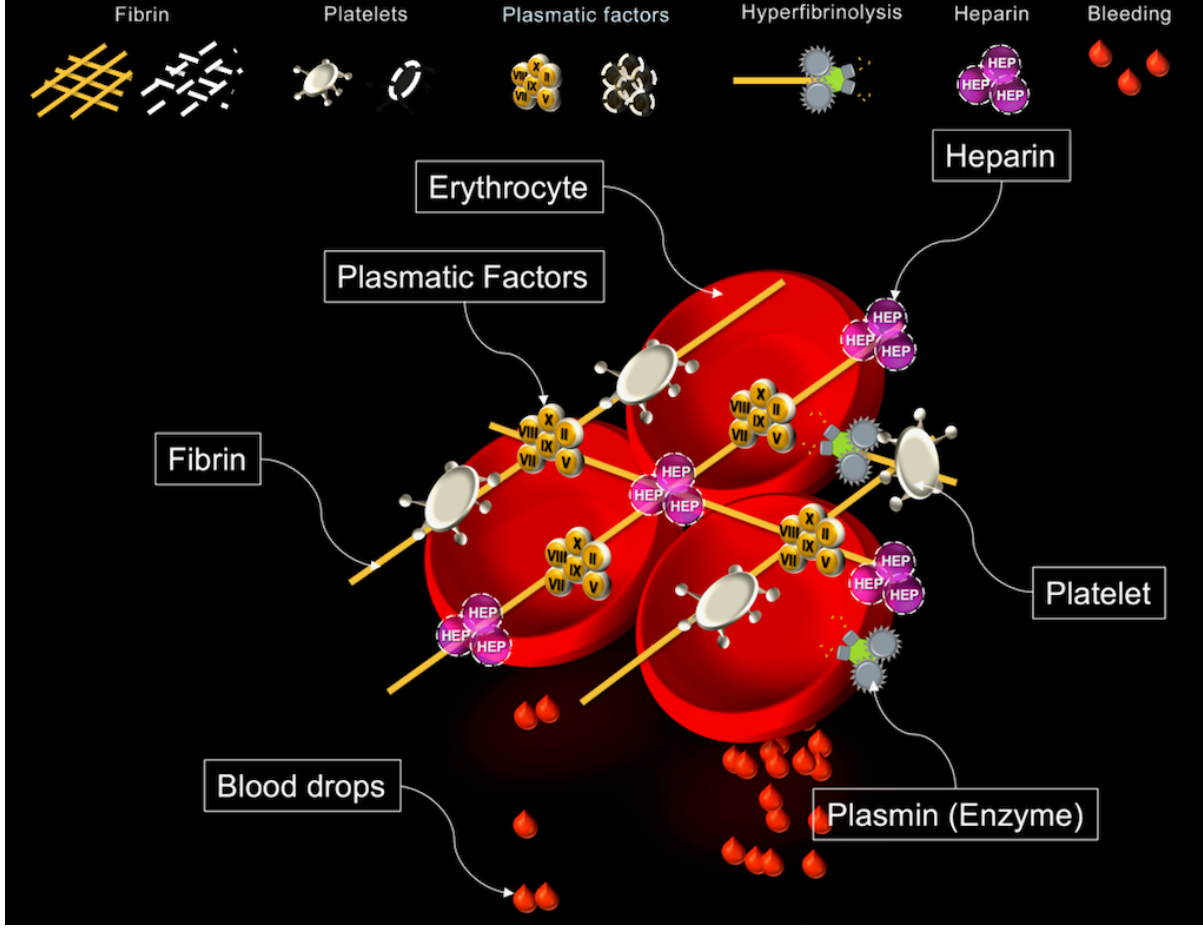
Figure 1. Example of the animated blood clot, Visual Clot. Blood drops are shown in cases of deficient hemostatic